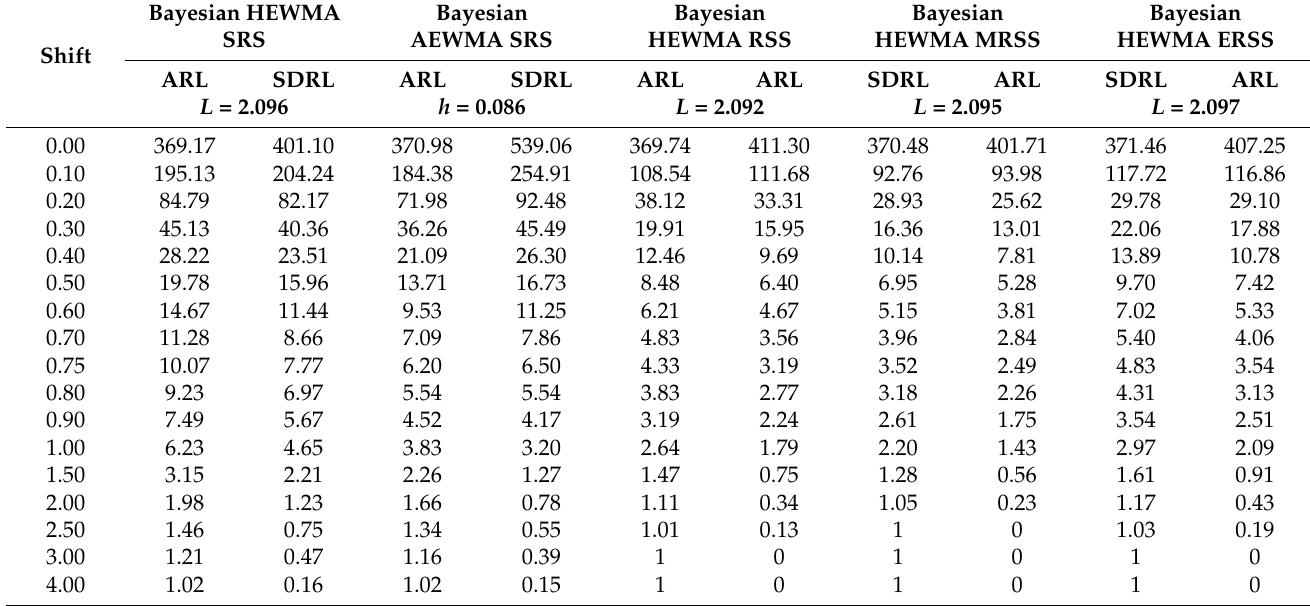
Table 3. The ARL and SDRL values of Bayesian HEWMA and Bayesian AEWMA control chart